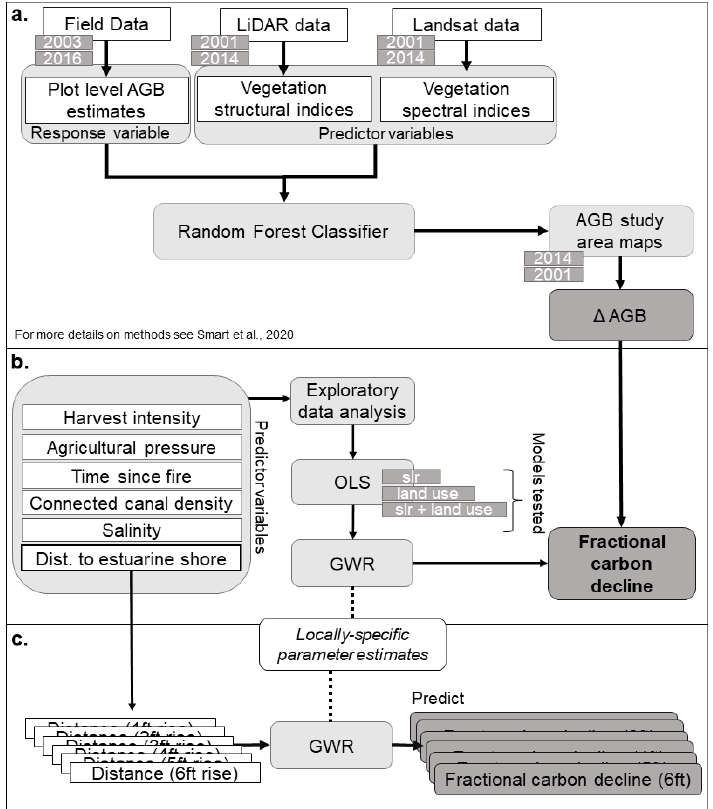
Figure 2. Schematic describing the three main analyses that include ( a ) mapping aboveground biomass (AGB) change and calculating fractional carbon decline (Section 2.2; for more details on methods [49]); ( b ) exploratory data analysis to select uncorrelated predictor variables and modeling fractional carbon decline as a function of sea level rise (slr), land-use, or a combination of drivers using nonspatial (ordinary least squares; OLS) and spatial (geographically weighted regression; GWR) regression models (Sections 2.3 and 2.4); and ( c ) using the locally specific parameter estimates established from the GWR model to predict future fractional carbon declines by holding all other variables constant and updating the distance to estuarine shoreline variable (Section 2.5).